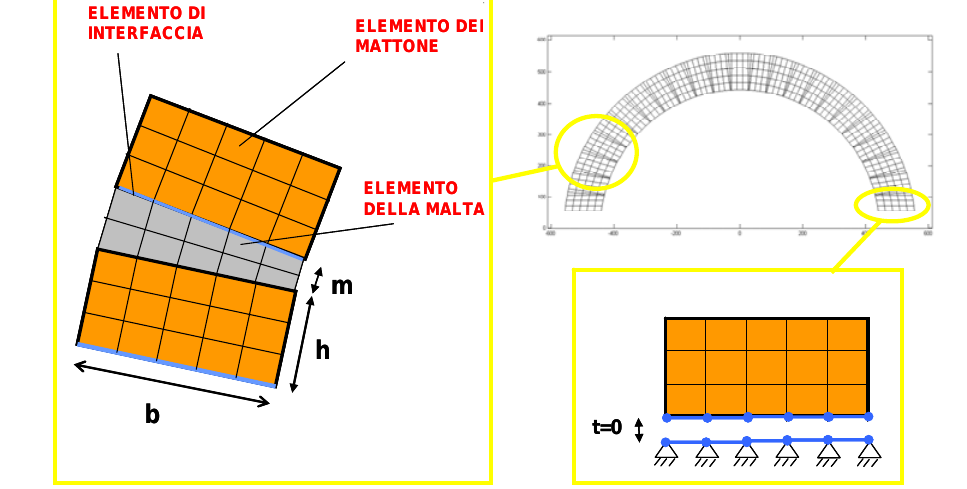
Figura 12: Discretizzazione ( n